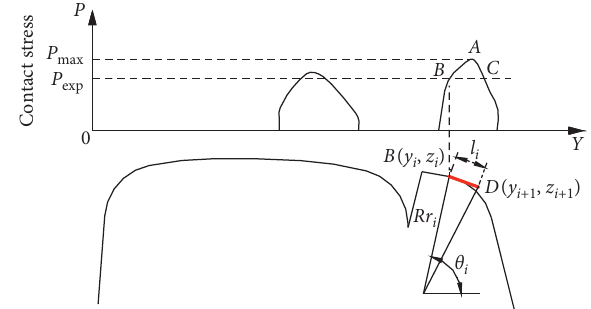
Figure 5: Schematic of rail profile design